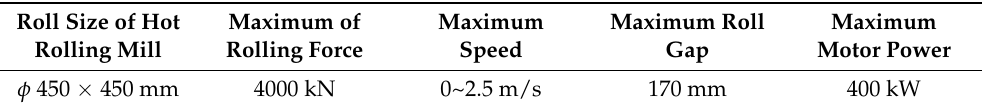
Table 3. Main equipment parameters of the hot rolling mill.